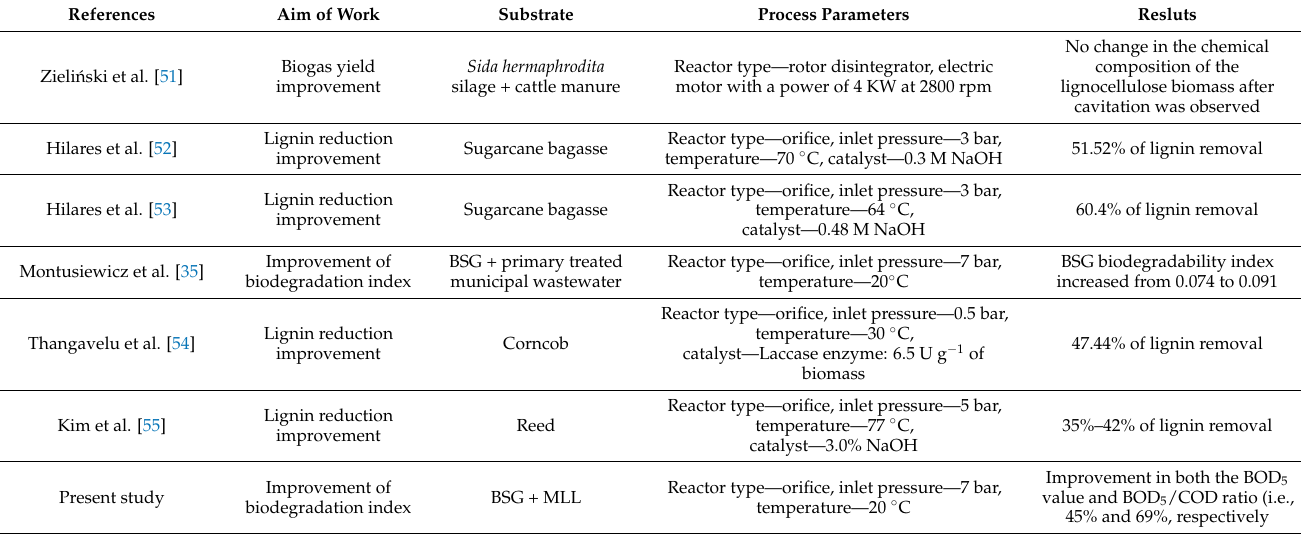
Table 4. Comparison of different hydrodynamic cavitation (HD) lignocellulosic biomass pretreatment